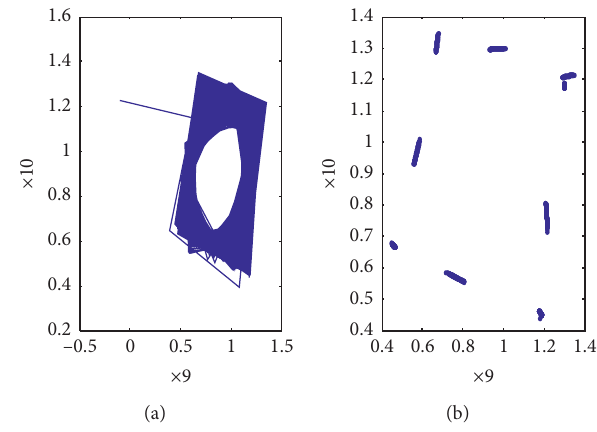
Figure 35: ω � 192 and k when t ∈ 0 . 05 0 . 0597 􏼂 􏼃 .